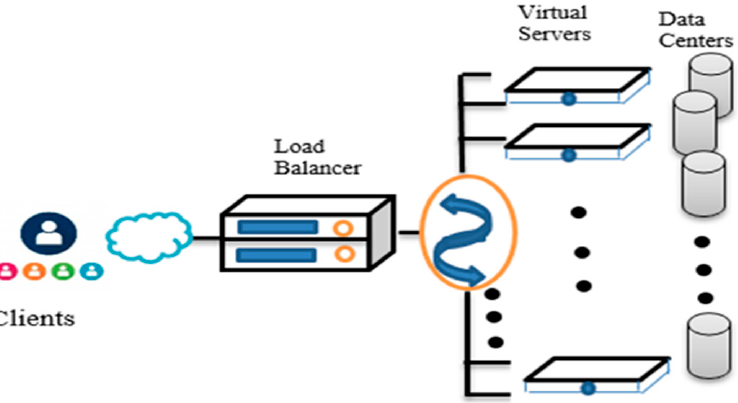
Figure 1. Mechanism of load balancing.